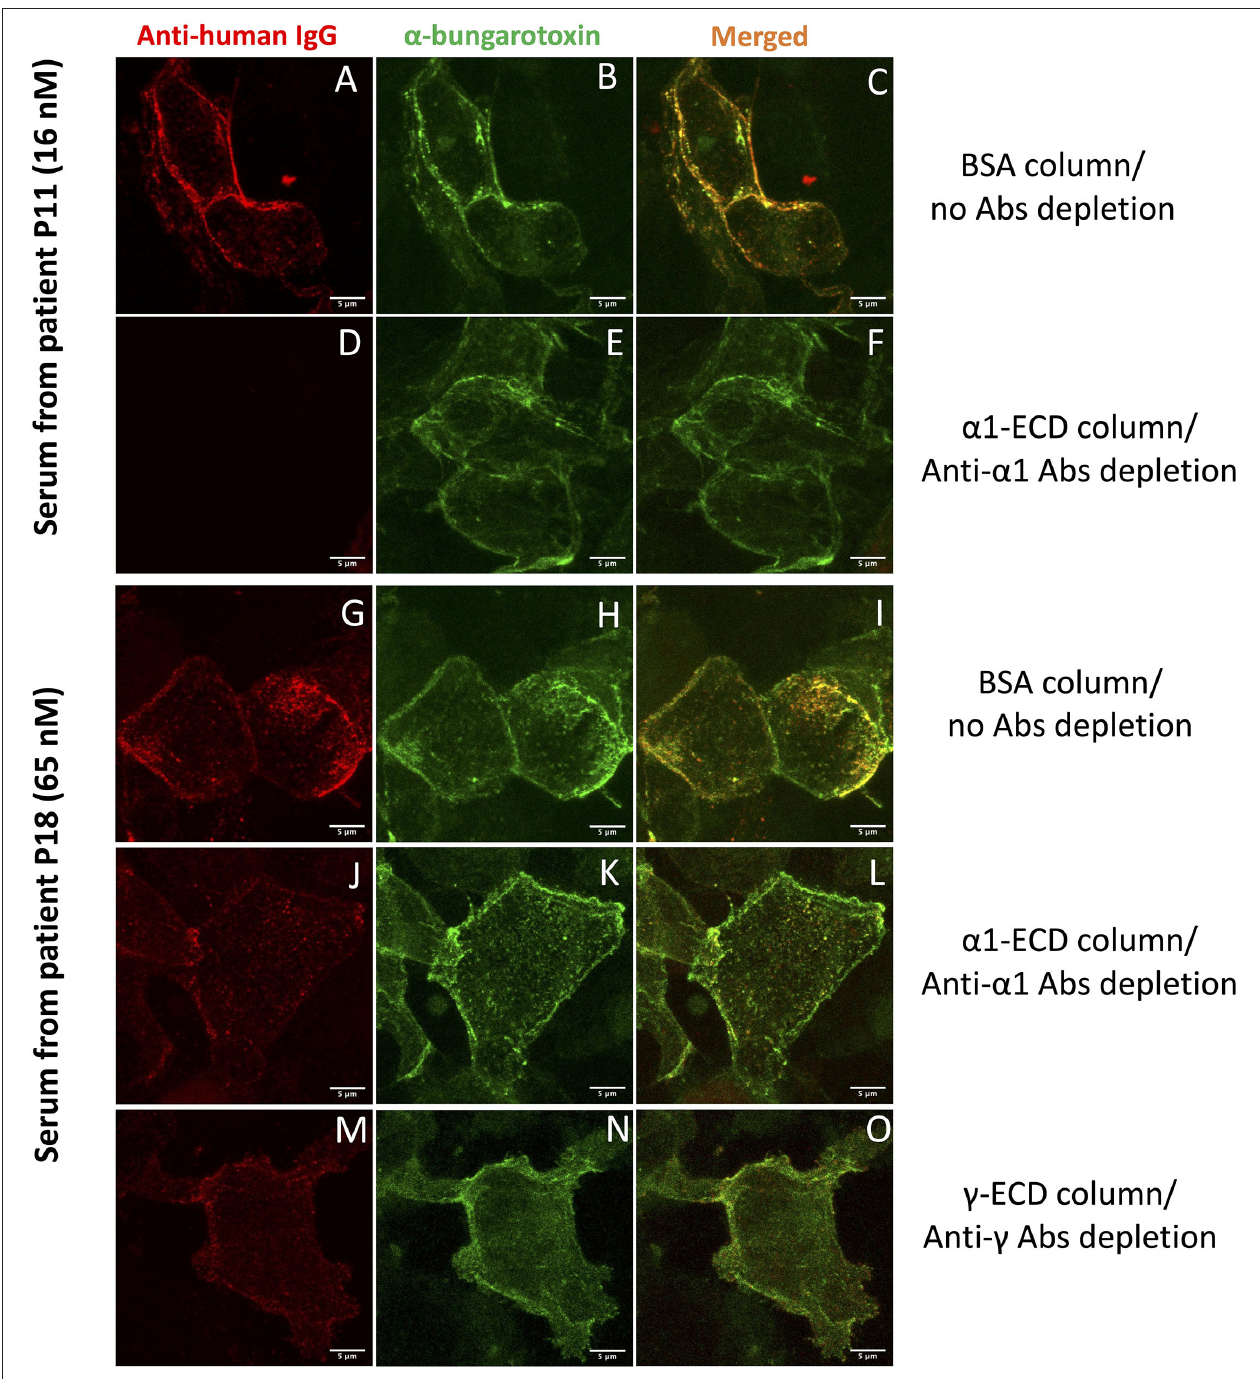
FIGURE 2 | Cell-based assay (CBA) performed with sera after the immunoadsorption assay. HEK293T cells overexpressing a mixture of adult and fetal subtypes of the nAChR were used in the assay. (A–F) show cells incubated with serum derived from the patient P11 treated with BSA sepharose beads (A–C) , where no autoAbs were depleted or treated with α 1-ECD sepharose beads (D–F) , where the anti- α 1 autoAbs were depleted. (G–O) show cells incubated with serum derived from the patient P18 treated with BSA (G–I) , α 1-ECD (J–L) , and γ -ECD (M–O) sepharose beads. The first column shows the binding of the specific anti-nAChR autoAbs contained in the serum, visualized by Alexa Fluor-555 labeled anti-human IgG Ab, the second column shows the total number of the nAChR on the cell surface of HEK293T stained with Alexa Fluor-488 labeled α -bungarotoxin. The third column shows merged confocal images of the anti-human IgG and α -bungarotoxin. Images were taken by Leica confocal TCS-SP8